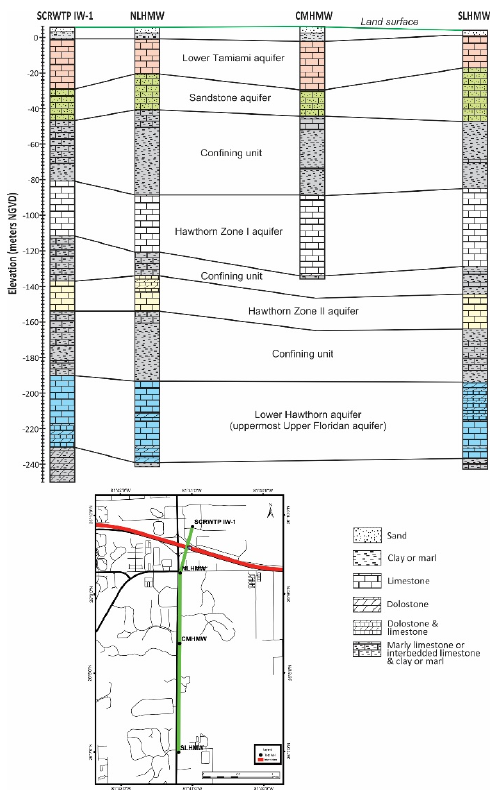
Figure 3. Stratigraphic cross ‐ section showing the variability in depths and thicknesses of the two production aquifers [32]. Characterization of the Hawthorn Aquifer Zone 1 was reported in CDM [32]. The aquifer consists of porous limestone with a moderate degree of heterogeneity. Test drill ‐ ing for geologic characterization of the Hawthorn Zone 1 aquifer found that it occurred between 91.5 and 137 m below surface. The thickness of the aquifer ranged from 30.5 and 45.7 m. An aquifer performance test was conducted from which transmissivity, storativ ‐ ity, and leakance values of 248 to 1242 m 2 /d, 1 × 10 − 4 to 1 × 10 − 5 , and 2.2 × 10 − 3 d − 1 , respec ‐ tively, were obtained. The dissolved chloride concentration in the aquifer ranged from 1800 to 2800 mg/L with an approximate TDS concentration ranging from 3350 to 4940 mg/L. The approximate TDS values were obtained from chloride data based on the rela ‐ tionship in this aquifer system [21]. The Lower Hawthorn Aquifer consists of porous limestone and dolomite units that exhibit considerable heterogeneity [32]. The aquifer occurs between 198 and 244 m below surface with a relatively uniform thickness of 46 m. Due to the extreme heterogeneity, the aquifer has a range in measured transmissivity of 124 to 3229 m 2 /d. The measured stora ‐ tivity is near 1 × 10 − 4 , and the leakance was estimated to be about 7 × 10 − 3 d − 1 . Based on the geology, aquifer testing results, and groundwater modeling, it was demonstrated that the pumping of the upper aquifer will have little impact on the overly ‐ ing freshwater aquifer system because of the confinement and the stark contrast in water quality across the confining unit. If the potentiometric surface in the aquifers is all con ‐ verted to freshwater heads, the potentiometric surface of the Hawthorn Aquifer Zone 1 containing brackish water is 3 to 5 m above the potentiometric surfaces of the Lower Ta ‐